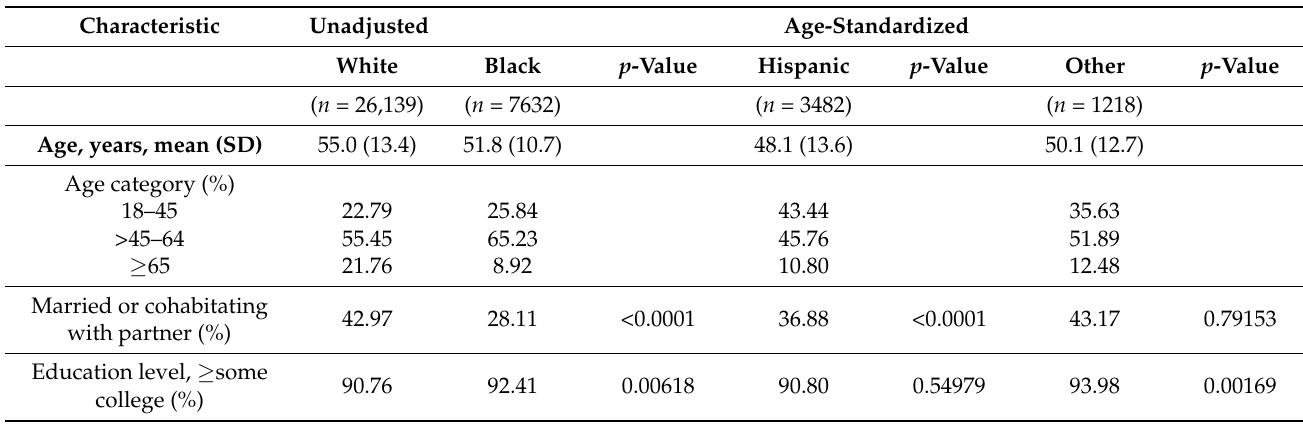
Table 2. Demographics, Lifestyle Characteristics, and Military Exposures of Women from the Million Veteran Program by Race and